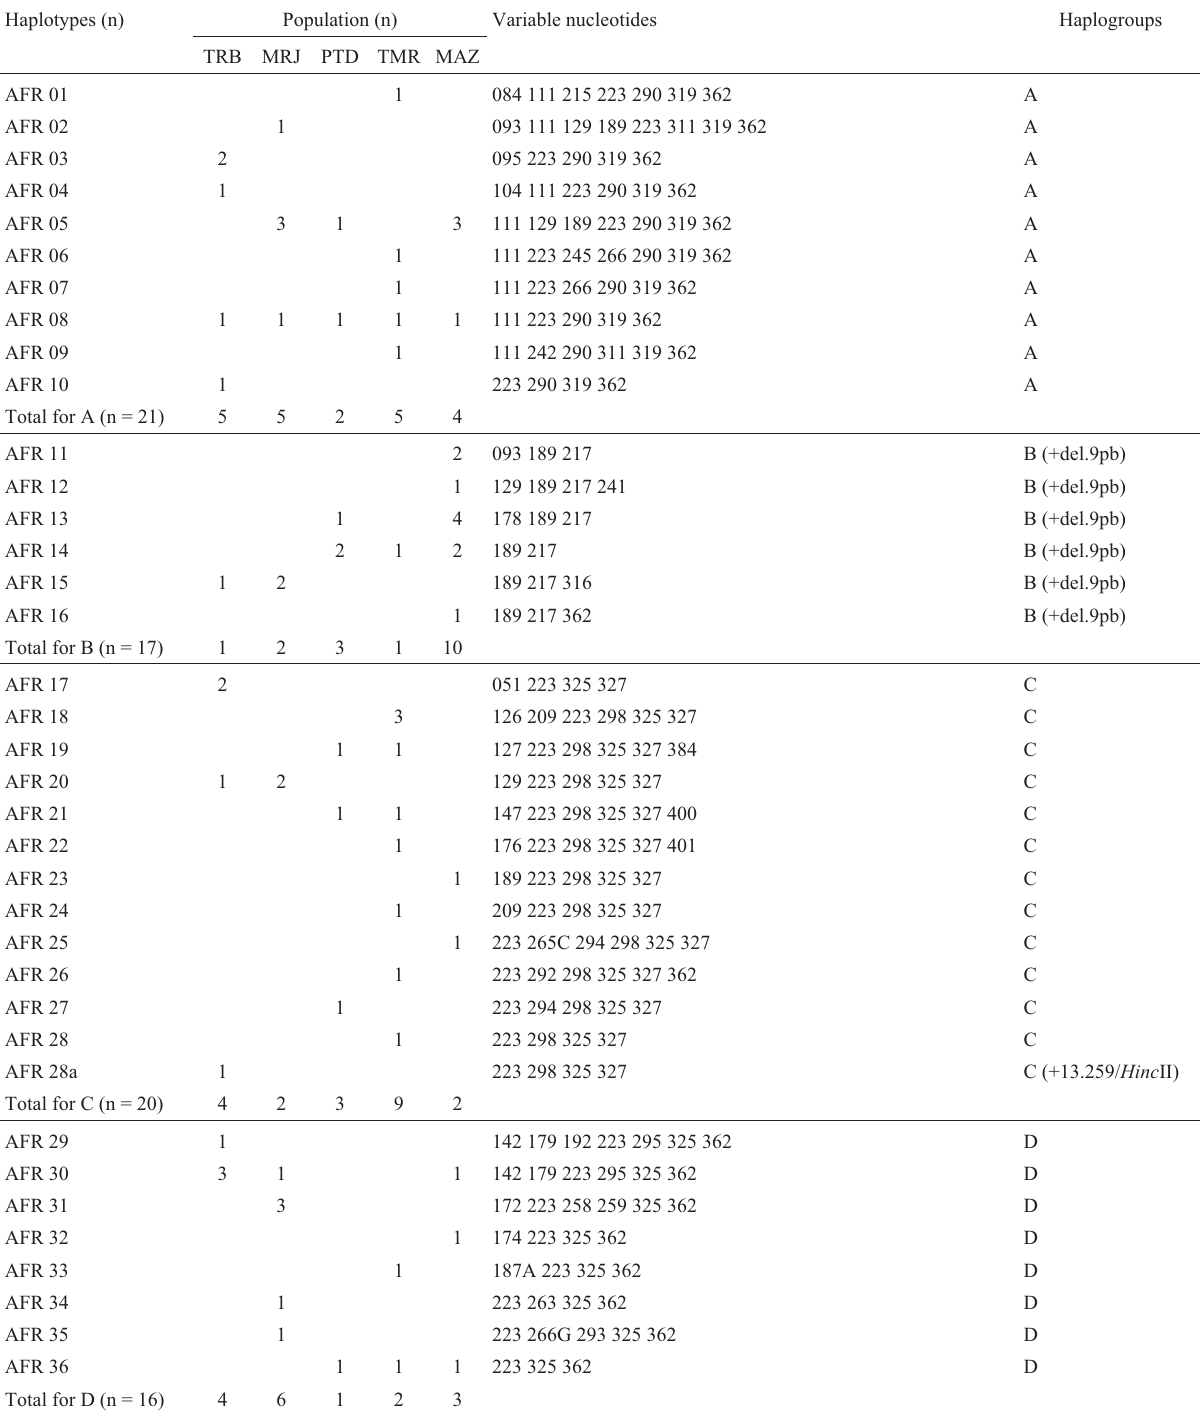
Table 1 - Haplotypes defined by first hypervariable region (HVS-I) variant nucleotides in samples of Afro-descendant populations from the Brazilian Amazon. Haplotypes characterized only by HVS-I region nucleotide variability. Haplotypes followed by the letter “a” ( e.g. , AFR 28a) also showed re- striction fragment length polymorphism (RFLP) variation and the 9 bp deletion. The population sample consisted of unrelated African-descendants (n = 159) living in five communities located in three states in the Brazilian Amazon region: Trombetas (n = 32), Marajó island (n = 34) and Pitimandeua (n=29)inParástate;ii)Tamauari(n=31)inMaranhãostate;andiii)Mazagão(n=33)inAmapástate.Inthe‘variablenucleotides’columnthenumbers indicatevariablenucleotidesaftercomparisonwiththeCambridge(CRS)referencesequenceoftheHVS-Iregion,16000mustbeaddedtothesenumbers for the exact nucleotide position. Transversions are indicated by the nitrogen base, and deletions by “del”. The final classification is given in the last col- umn.ResultsinparenthesescorrespondtotheinitialanalysisofthreeRFLPandthe9bpdeletion.Inthehaplotypecolumn‘n’representsthetotalnumber of individuals with the cited haplotype, while in the population column it represents the number of individuals per